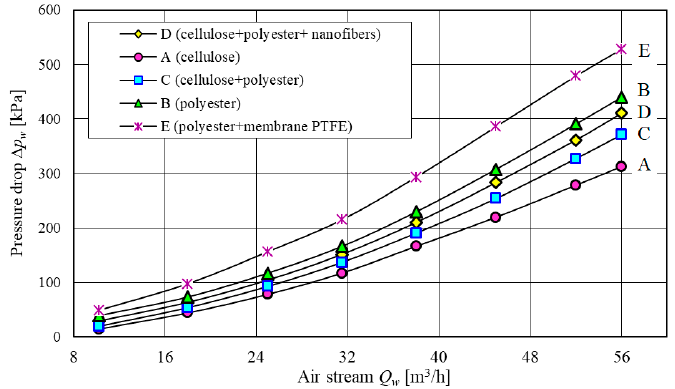
Figure 4. Flow characteristics Δ p w = f ( Q w ) of the tested filter elements.